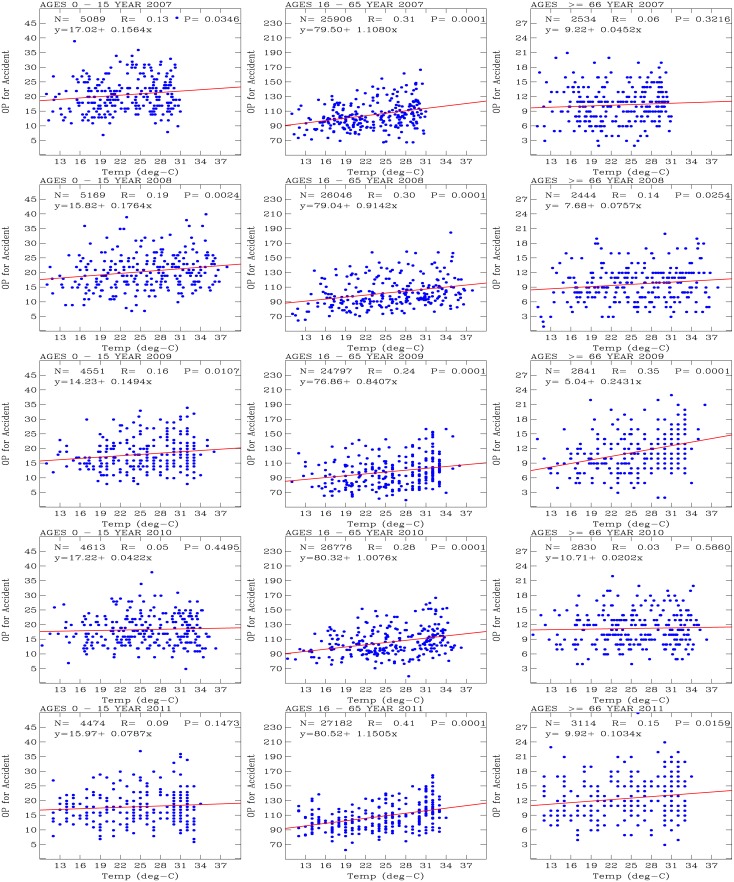
Scatter plots of daily number of outpatients for accidents (y-axis) versus temperature (x-axis).The 3 age groups of outpatients are shown in the left (0–15 years old), middle (16–65 years old), and right (greater than 66 years old) panels; the years are arranged from top (2007) to bottom (2011). Red lines show the results of a univariate regression performed on the data, with sample number N, correlation coefficient R, and measure of correlation significance P.